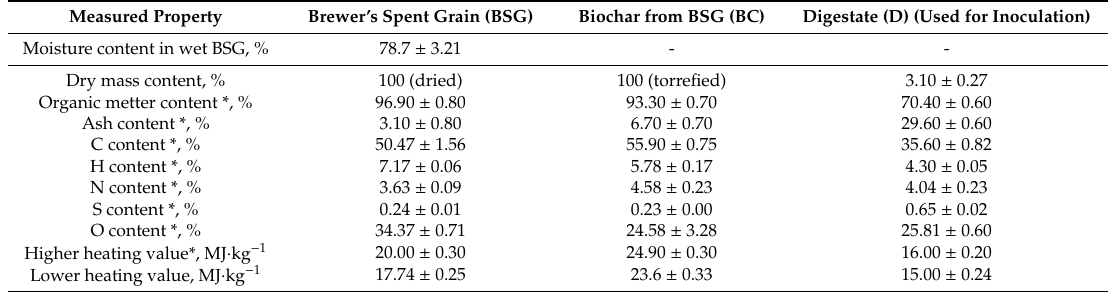
Table 1. Properties of brewers’ spent grain, biochar, and digestate used in the experiment. Measured Property Brewer’s Spent Grain (BSG) Biochar from BSG (BC) Digestate (D) (Used for Inoculation) Moisture content in wet BSG,